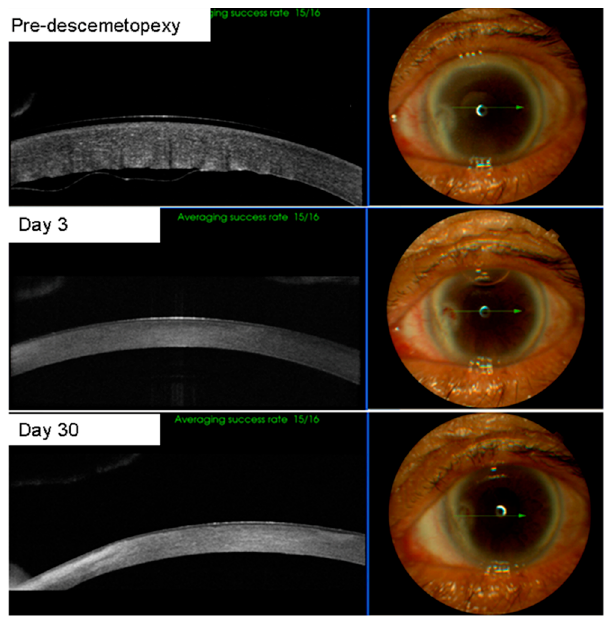
Figure 3. Clinical course of descemetopexy in case 3. The patient received a repair algorithm proce- dure and Descemet’s membrane (DM) was successfully reattached.